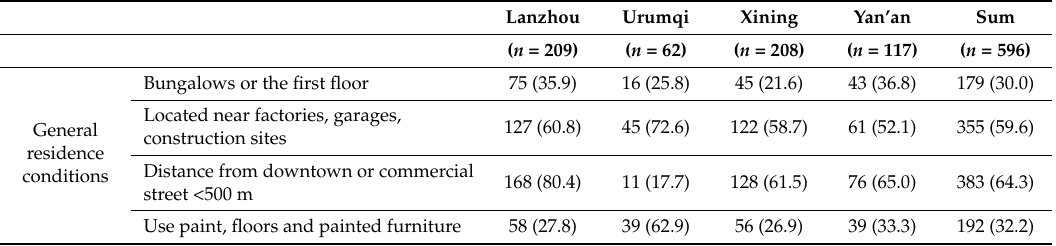
Table 13. General residence conditions in different